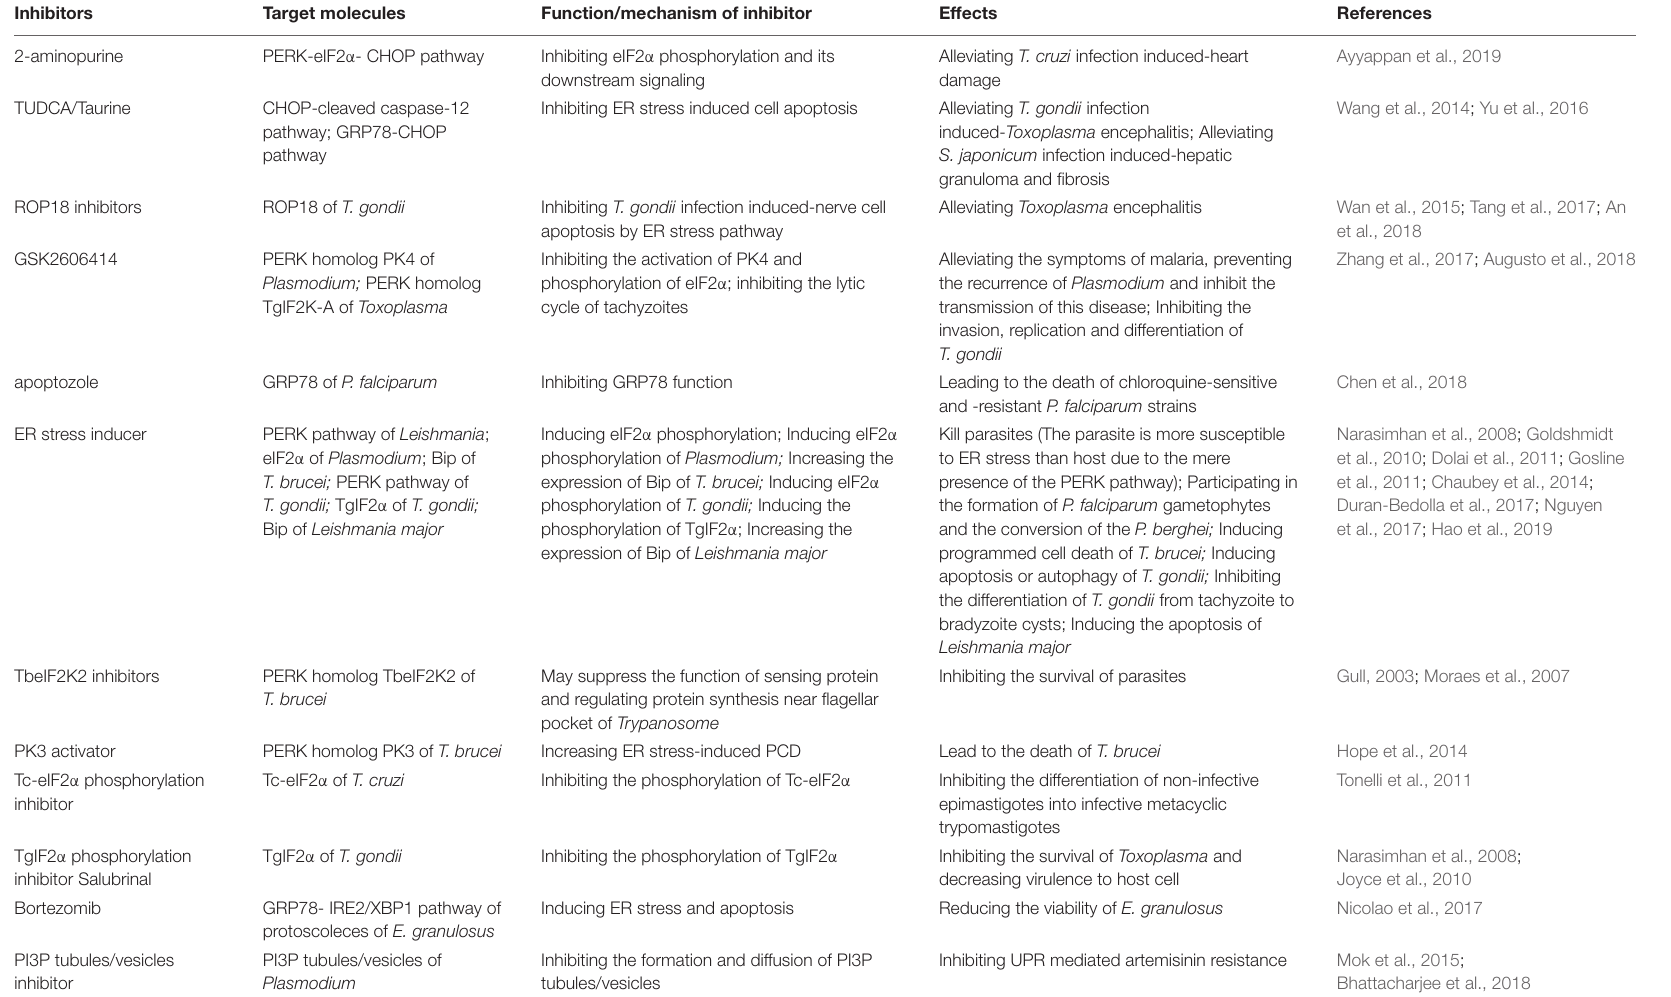
TABLE 1 | Potential drug targets of UPR for treatment of